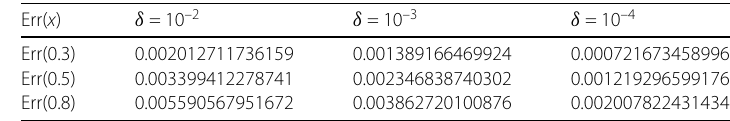
Table 1 The error between the exact and regularized solutions at δ ∈ { 0.01,0.001,0.0001 } and x ∈ { 0.3,0.5,0.8